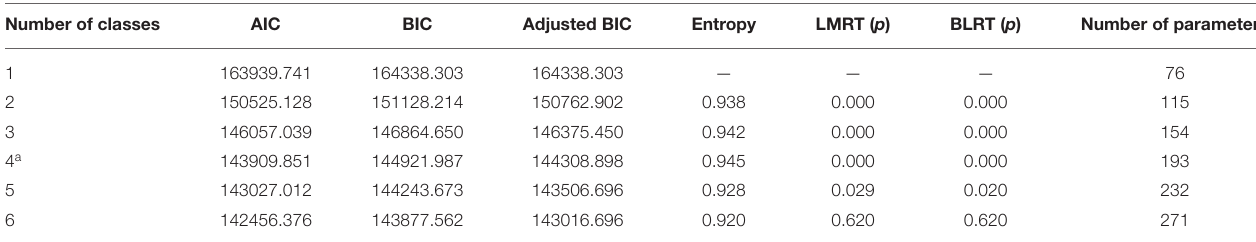
TABLE 2 | Model fit information for competing latent class models ( N = 1,400). Number of